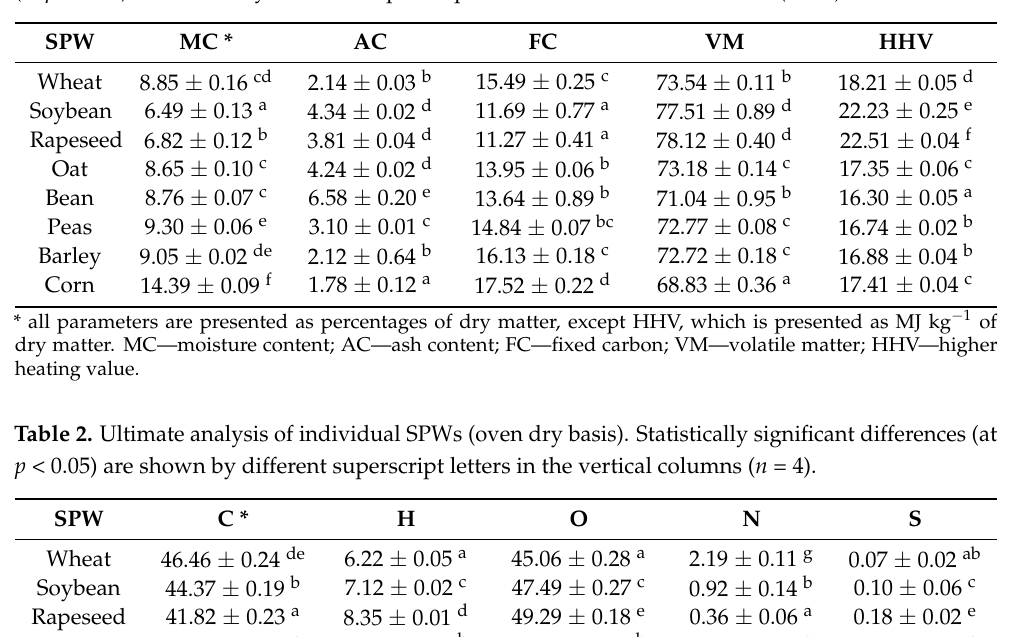
Table 1. Proximate analysis of individual SPWs (oven dry basis). Statistically significant differences (at p < 0.05) are shown by different superscript letters in the vertical columns ( n = 4).